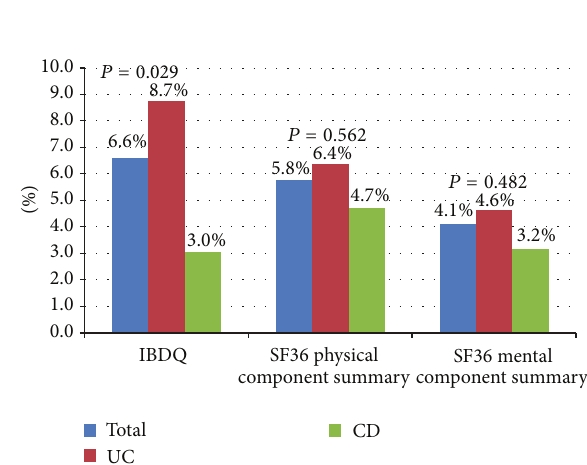
Figure 2: Percentage changes according to baseline in QoL